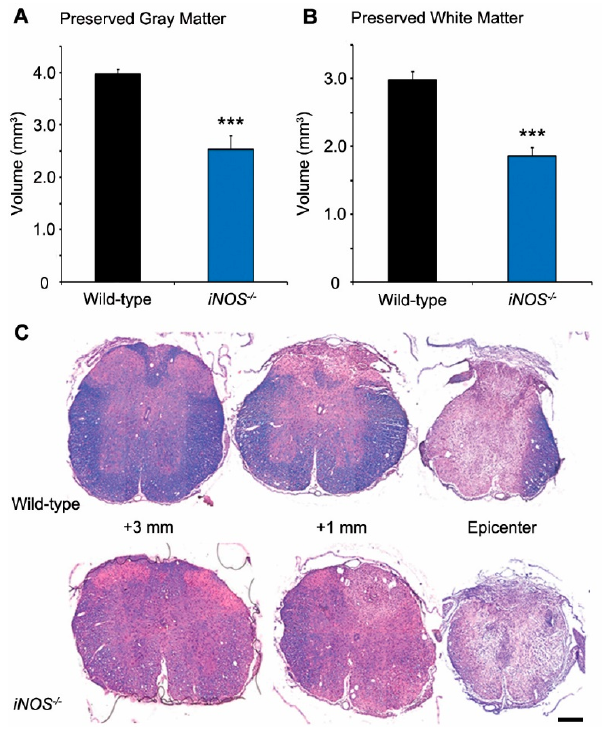
Figure 1. White and gray matter tissue preservation after spinal cord injury (SCI) was significantly less in inducible nitric oxide synthase (iNOS) knockout mice compared to wild-type (WT) controls. At week six, post-SCI, iNOS − / − and WT mice showed significant reductions in the volumes of healthy gray and white matter within the injured spinal cord segment. Compared to WT animals, iNOS − / − had smaller volumes of preserved white ( A ); and gray ( B ) matter after SCI; ( C ) Representative transverse sections stained with hematoxylin, eosin, and luxol fast blue from WT and iNOS − / − mouse spinal cord tissue at the injury epicenter, as well as 1 and 3 mm rostral. Statistical significance indicated at *** p < 0.001 versus injured WT controls. Scale bar = 150 µm.